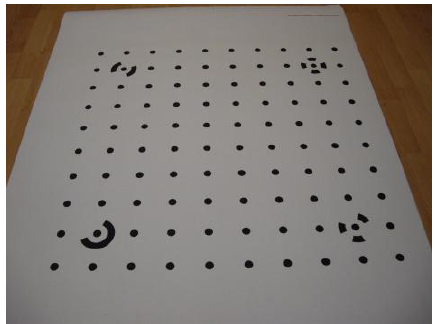
Figure 3. Lab camera calibration